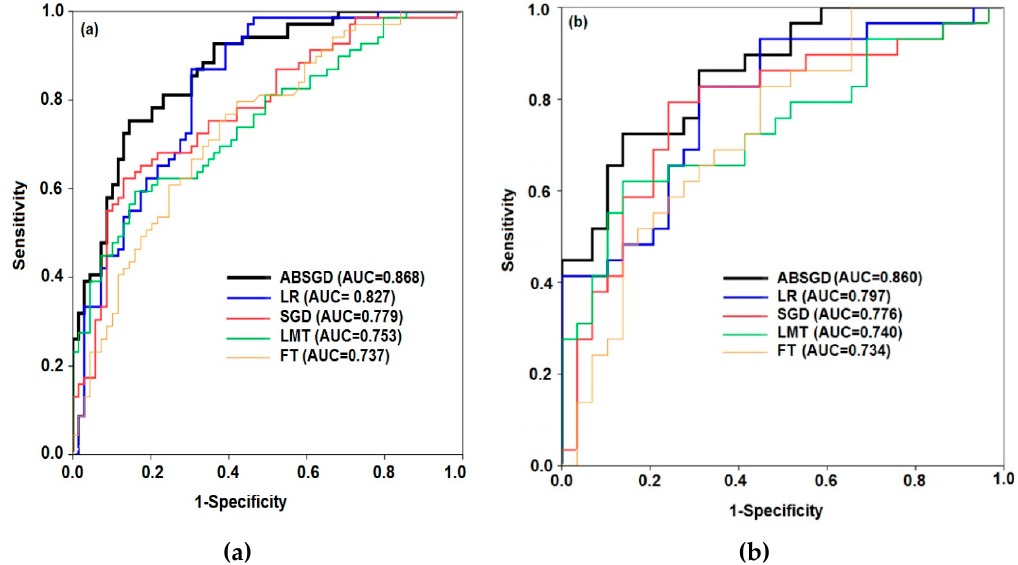
Figure 6. Area under the ROC curve (AUCs) of the models using: (a) training dataset and (b) validation dataset.